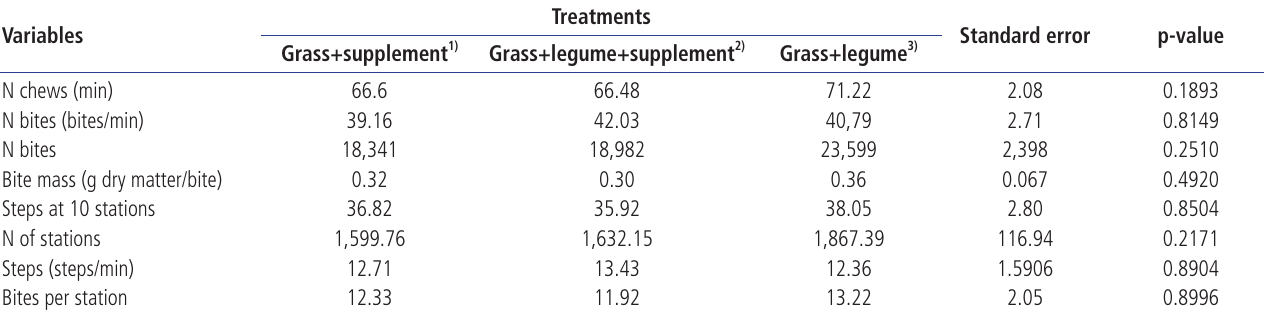
Table 5. Feeding behavior of beef steers in oat and ryegrass pastures mixed or not with vetch and with or without energy supplementation